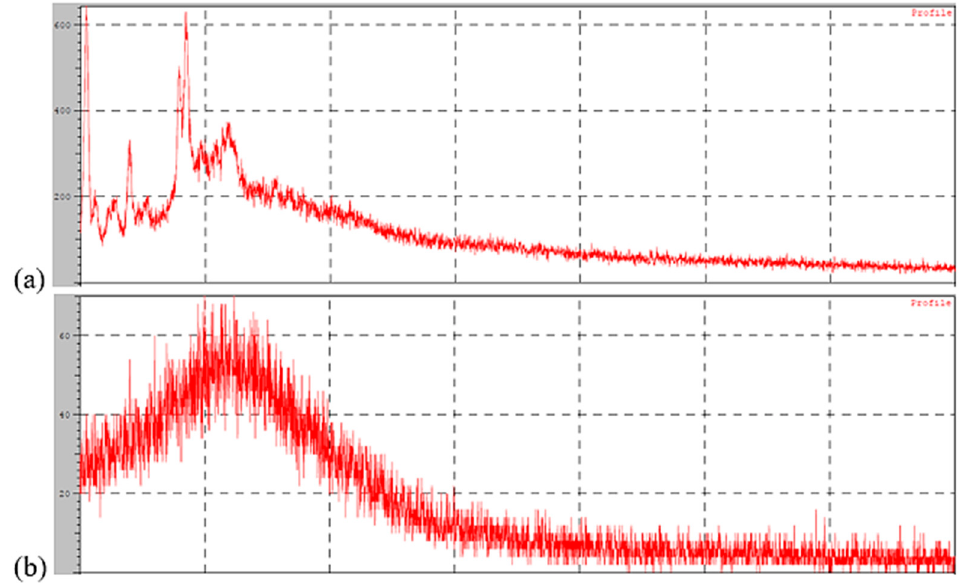
Figure 8. X-ray Diffraction Pattern of ( a ) pure FLV ( b ) optimized formulation.